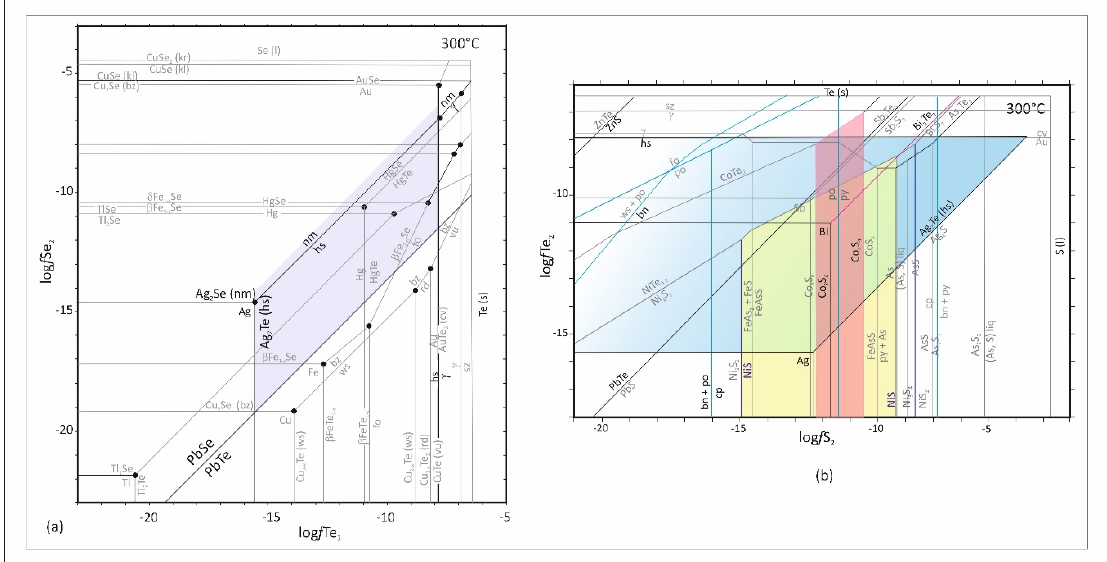
Figure 17. Phase relations for selenides and tellurides ( a ) and for selenides, tellurides and sulfides ( b ) in function of log f Te 2 , f Se 2 and f S 2 at 300 °C by [57,112–115]. The colored areas represent stability fields